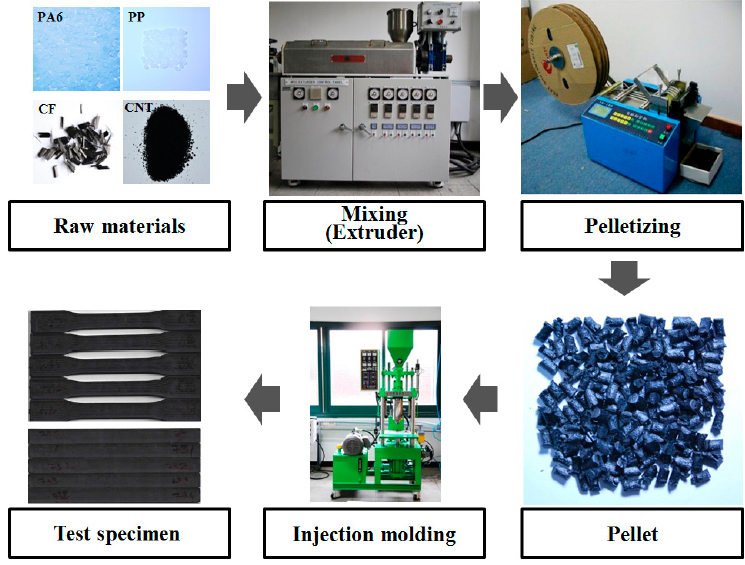
Figure 1. Sample preparation procedure. Table 1. Summary of material mixing ratios.